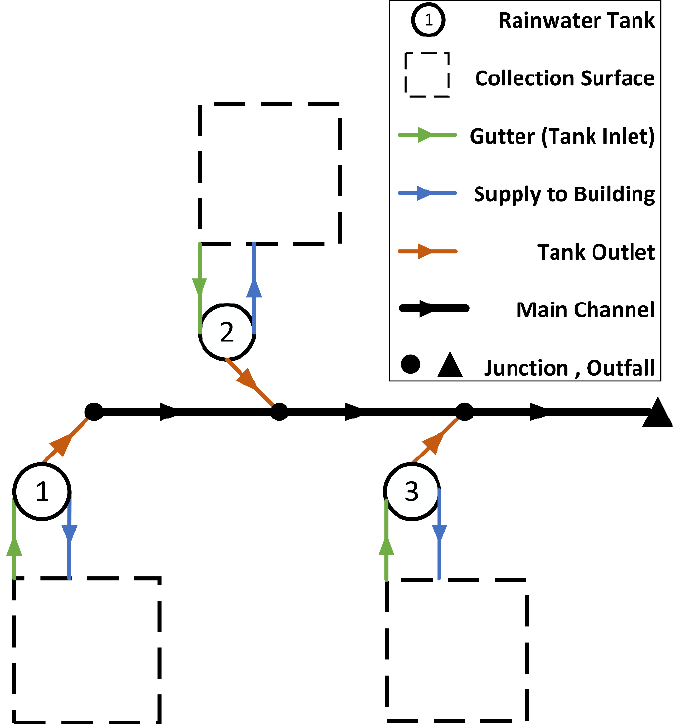
5 of 24 Table 1. Hydraulic characteristics of the modeled drainage system pipes.